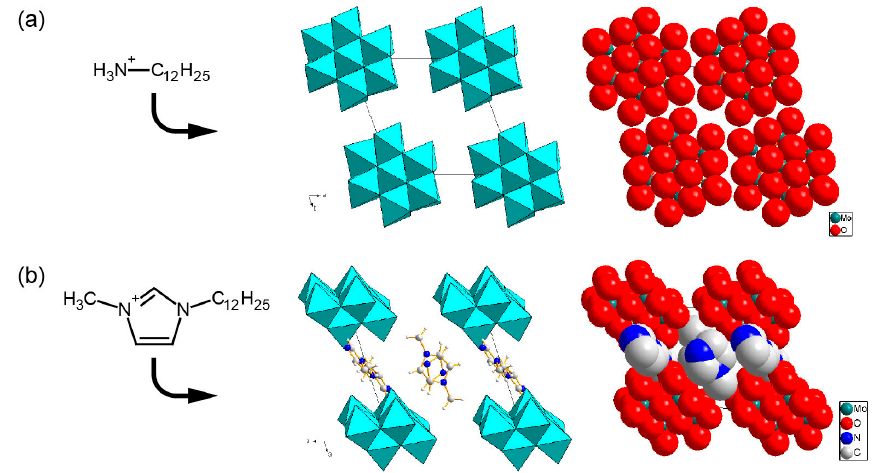
Figure 10. Molecular arrangements of the inorganic layers in β -Mo 8 hybrid crystals. The same arrangements are depicted in polyhedral (left) and space-filling (right) representations. ( a ) C 12 NH 3 - β -Mo 8 ; ( b ) C 12 mim- β -Mo 8 [123]. Reproduced with permission from Ito, T. et al. , Chem. Lett. ; published by The Chemical Society of Japan, 2013.